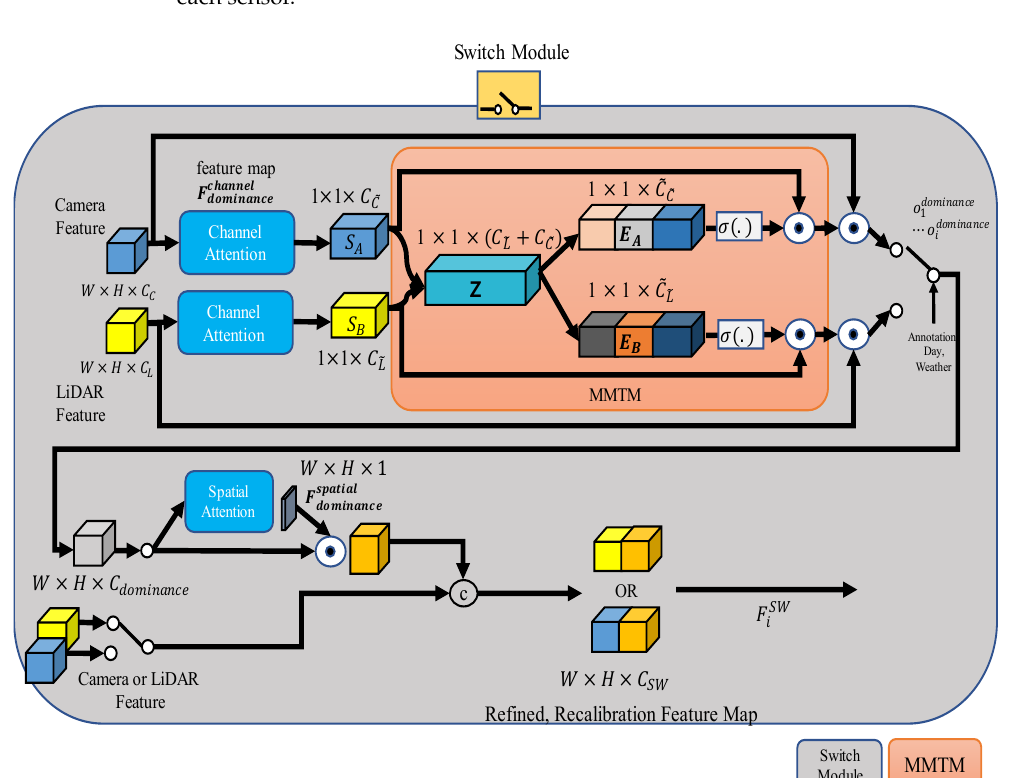
Figure 3. Structure of network with a feature switch module. CBAM [20] and MMTM [19] are applied to each input, and the recalibrated features are selected and processed using annotation.